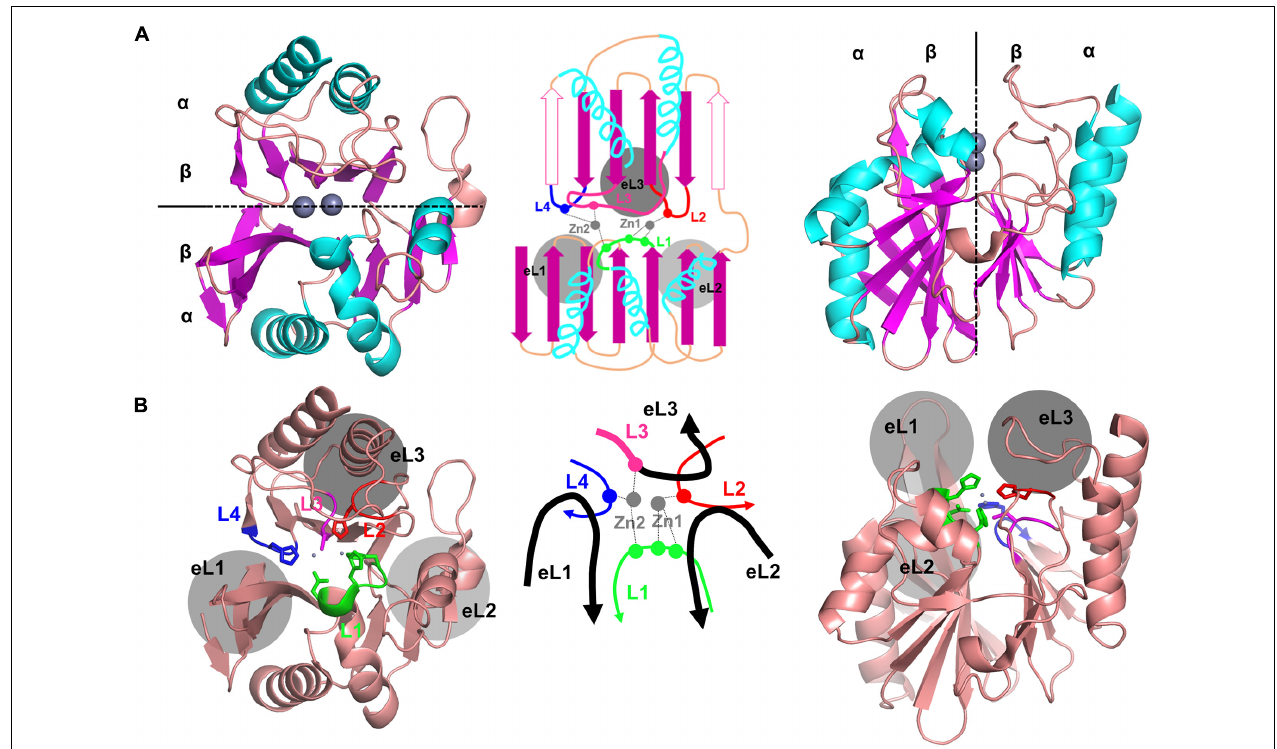
FIGURE 1 | The crystal structure of NDM-1, showing the representative core scaffold of MBLs. (A) The αβ / βα sandwich fold of NDM-1, which is the core scaffold of MBLs, is shown at the top (left) and side (right). The schematic representation is shown in the middle. The central two β -sheets and the five α -helices in the main scaffold are shown in purple and cyan, respectively. The two zinc ions are shown in gray. Certain β -strands in the second β -sheet exist as α -helices in some MBLs, which are shown as open purple arrows in the schematic representation (middle). (B) The overall structure of NMD-1 with the zinc-coordinating central loops L1–4 and the substrate-binding pocket forming the external loops eL1–3. The schematic representation of the central and external loops with zinc ions is shown in the middle. L3 is the N-terminal part of